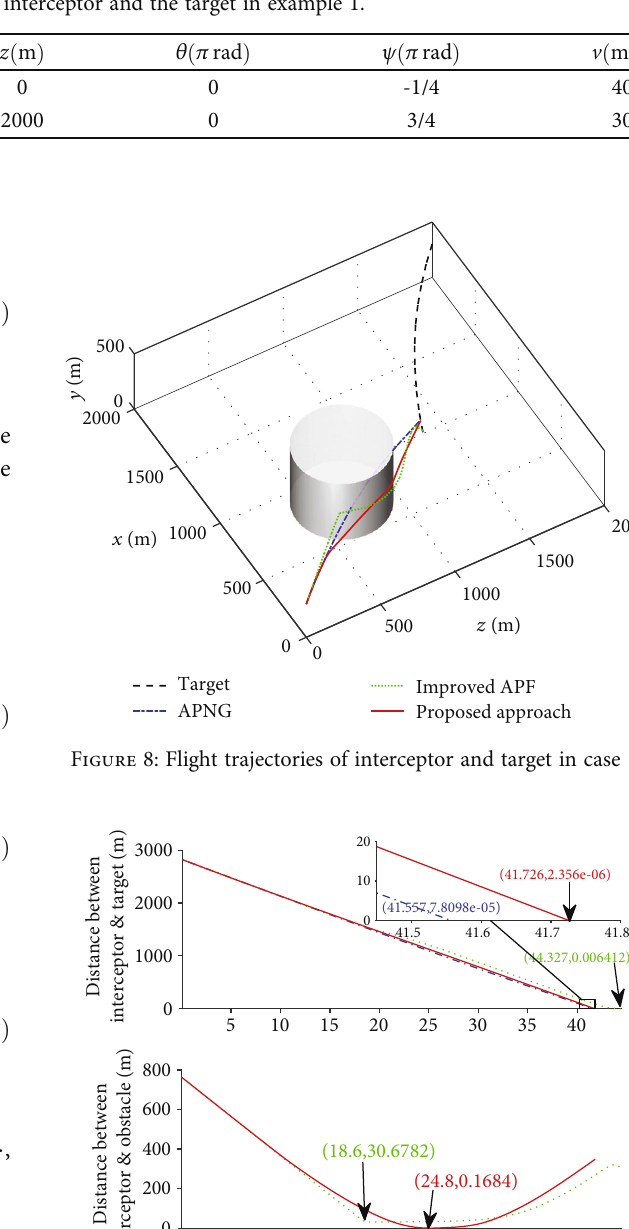
Table 2: The initial states of the interceptor and the target in example 1.